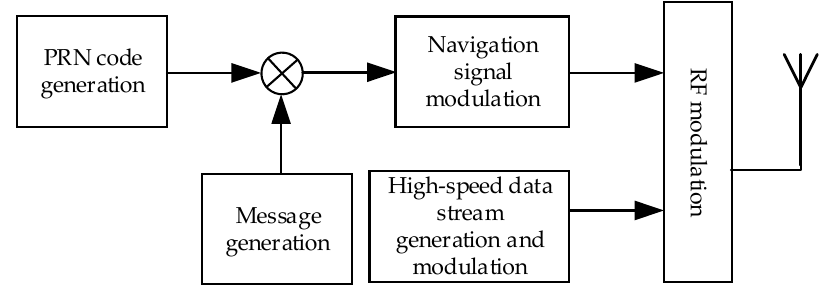
Figure 1. Flowchart of communication and navigation fusion signal generation.